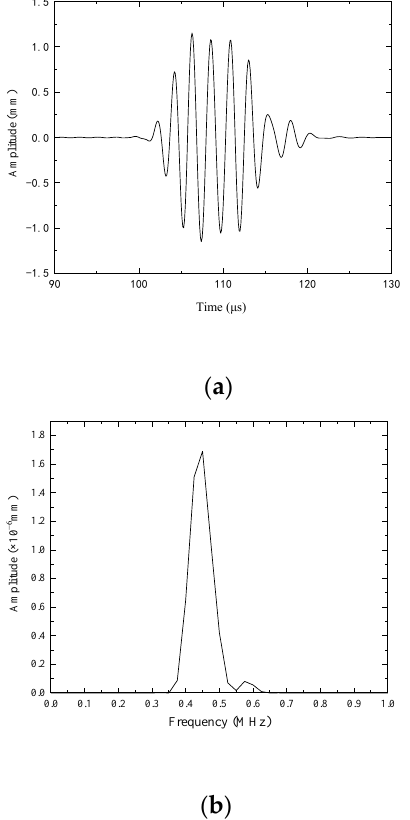
Figure 28. The time domain waveform ( a ) and PSD ( b ) of a received signal. The influence of defect depth on reflected and transmitted signals of surface waves is shown in Figures 29 and 30, respectively. The red curve represents the peak-to-peak amplitude, corresponding to the left Y axis, and the blue curve represents the maximum of the PSD function, corresponding to the right Y axis. Whether it was the peak-to-peak amplitude or the maximum of the PSD function, the characteristics of the reflected signal gradually increased with the increase of the defect depth; the characteristics of the transmitted signal gradually decreased with the increase of the defect depth. The difference was that the characterization curve of the maximum of the PSD function was smoother, and the difference of different defect depths was more obvious, since the PSD function was less interfered with by the overlap and transformation of wave packets and noise, which shows that it is more suitable for quantitative detection of groove-shaped defects.